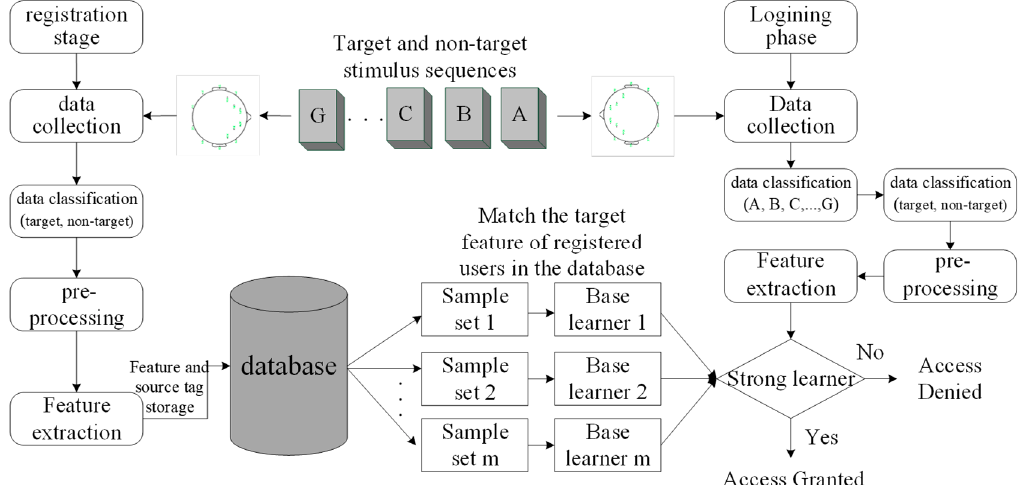
Figure 2. Three subsystems contained in the entrance authentication system .